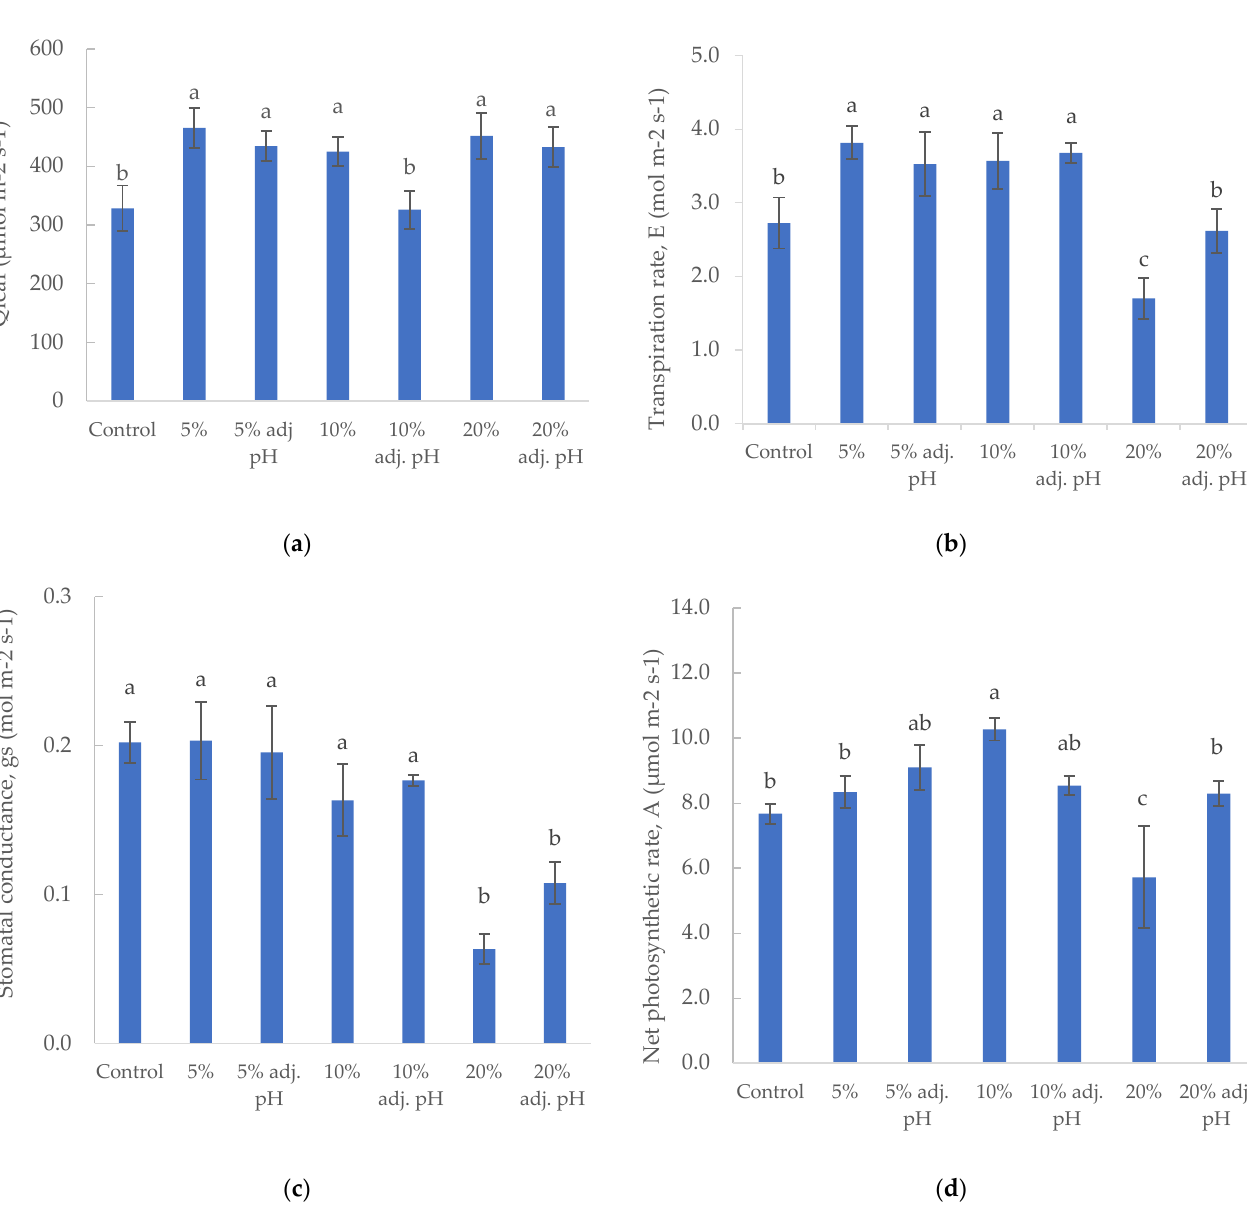
Figure 4. Photosynthetic parameters (Q leaf : photosynthetic active radiation ( a ), Ε: transpiration rate ( b ), gs: stomatal conductance ( c ), and A: net photosynthetic rate ( d )) of baby lettuce cultivated under different digestate solutions. Columns (means ± SE) with different letters are significantly different ( p < 0.05).